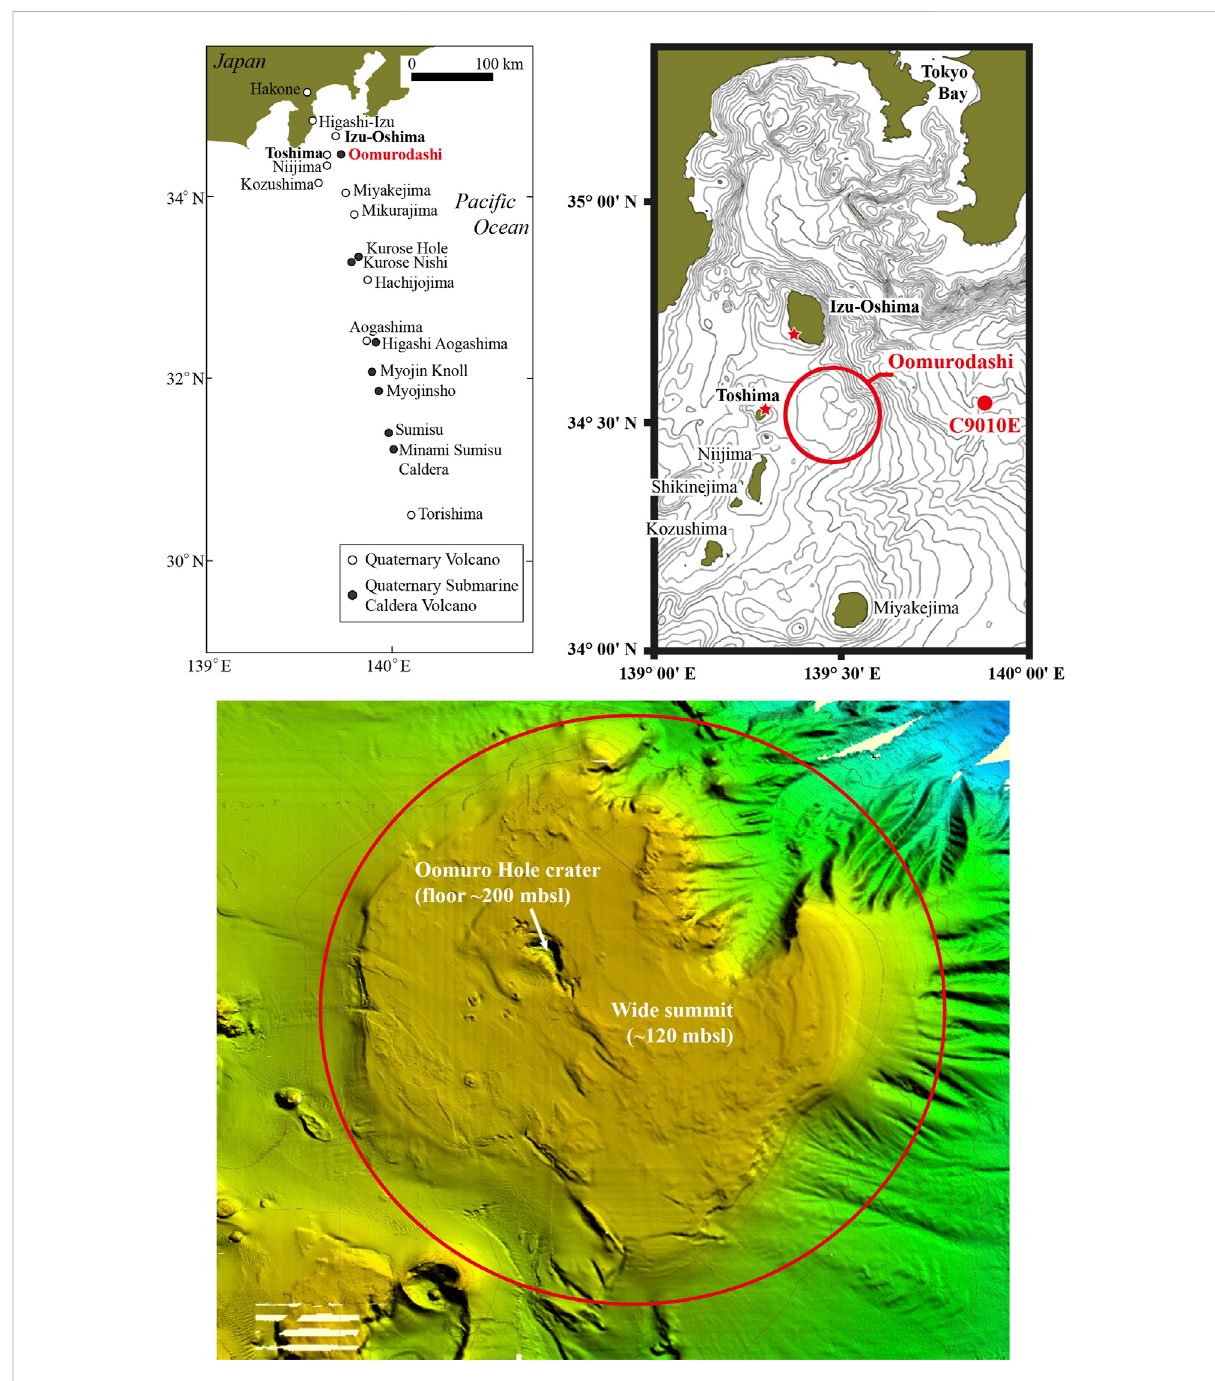
FIGURE 2 Location of the shallow submarine Oomurodashi volcano in the northern Izu-Bonin arc. Bathymetry collected during cruises NT12-19 of R/V Natsushima and KS-16-6 of R/V Shinsei-maru . Red circle encompasses the broad Oomurodashi edi fi ce. The small Oomuro Hole crater is located in the wide fl at summit area and hosts an active hydrothermal fi eld. Red dot indicates location of the C9010E core drilled by D/V Chikyu . Red stars indicate location of subaerial tephra layers O58 on Izu-Oshima and O3T on Toshima